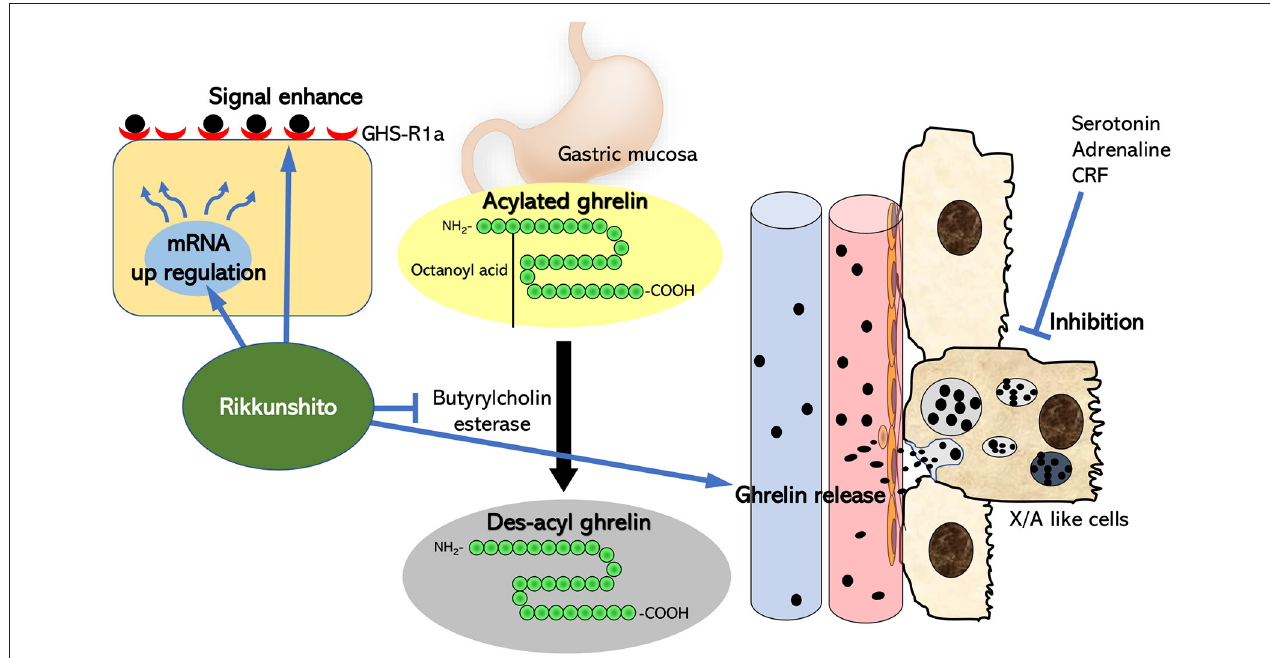
FIGURE 1 | Summary of the mechanism of action of rikkunshito as a ghrelin enhancer. Ghrelin is produced from X/A-like cells near the gastric mucosa, and the ghrelin receptors at the ends of the vagus nerve in the surrounding tissues are stimulated. Most of it migrates to blood vessels and is carried to the brain. Serotonin, adrenaline, and CRF negatively regulate ghrelin secretion in the periphery. Rikkunshito suppresses the decrease in ghrelin that occurs in diseases by antagonistically acting on these factors with receptors in the periphery or central nervous system. Furthermore, rikkunshito enhances the binding of ghrelin to the ghrelin receptor